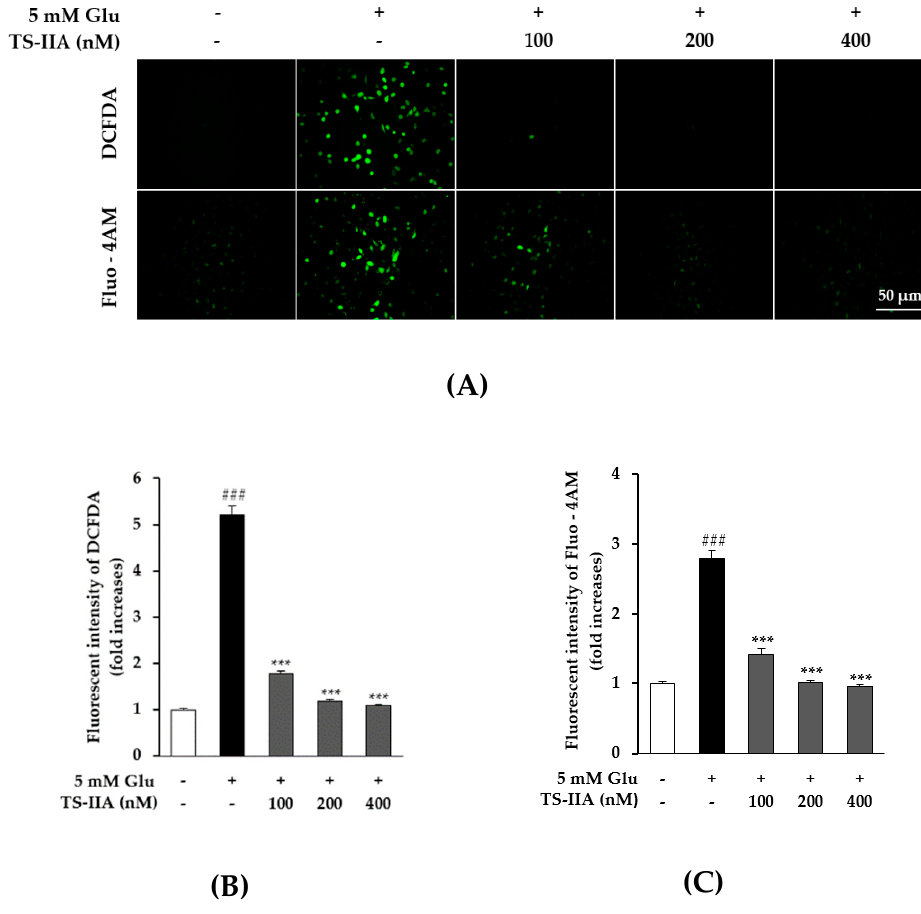
Figure 3. Inhibitory e ff ect of tanshinone IIA (TS-IIA) on intracellular reactive oxygen species (ROS) production and calcium accumulation following glutamate treatment. ( A ) A total of 10,000 cells were seeded in each well of a 96-well plate and incubated for 24 h. Subsequently, the cells were exposed to 100, 200, and 400 nM TS-IIA in the presence or absence of 5 mM glutamate for 10 h and stained with DCFDA or Fluo-4 AM. Fluorescent images were captured by fluorescence microscopy (20 × ). ( B ) TS-IIA attenuated production of ROS induced by glutamate ( N = 3). ( C ) TS-IIA decreased calcium concentration caused by glutamate ( N = 3). Notes: ### p < 0.001 compared with the untreated group, *** p < 0.001 compared with the glutamate-treated group. (TS- IIA: tanshinone IIA, Glu: